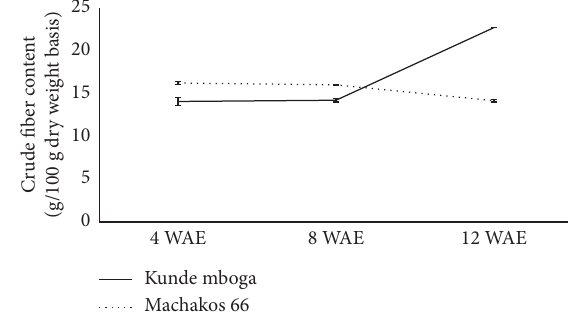
Figure 1: Efect of the interaction between crop variety and weeks after emergence (WAE) on crude fbre content of cowpea leaves. Error bars indicate the standard error of the means.